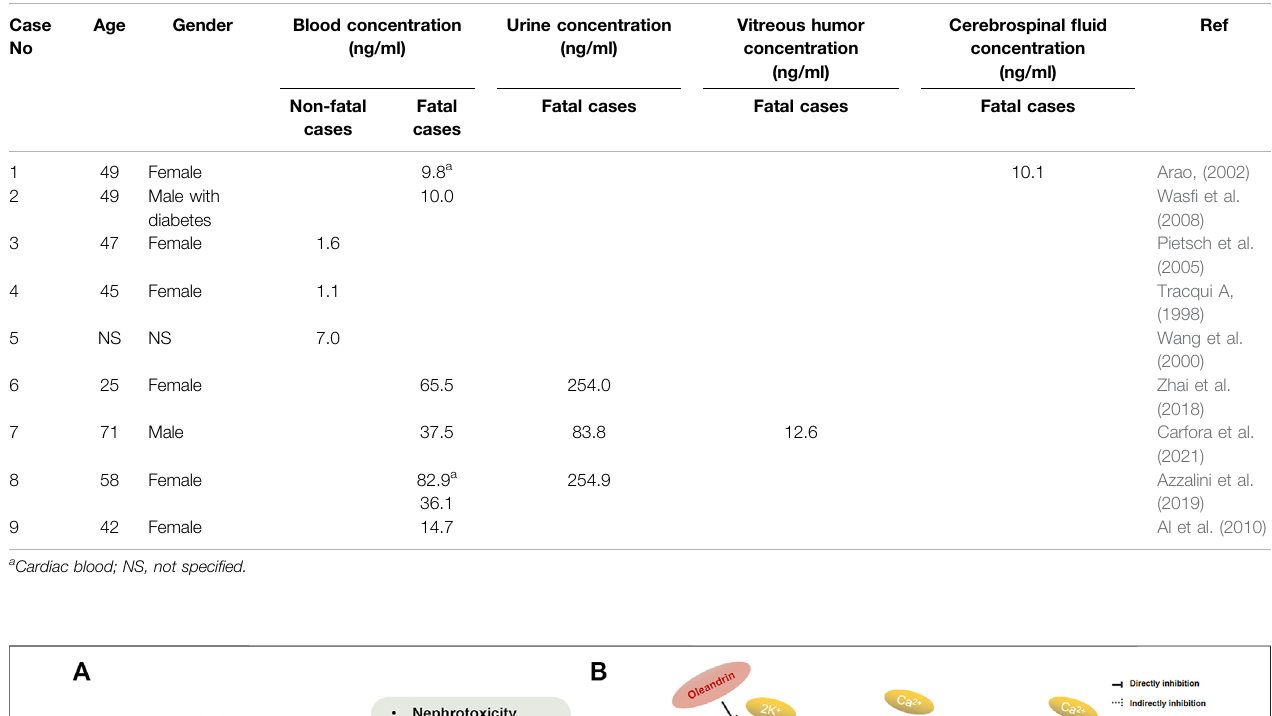
TABLE 2 | Summary of oleandrin concentration in biological liquids in reported intoxication cases of oleander in humans.